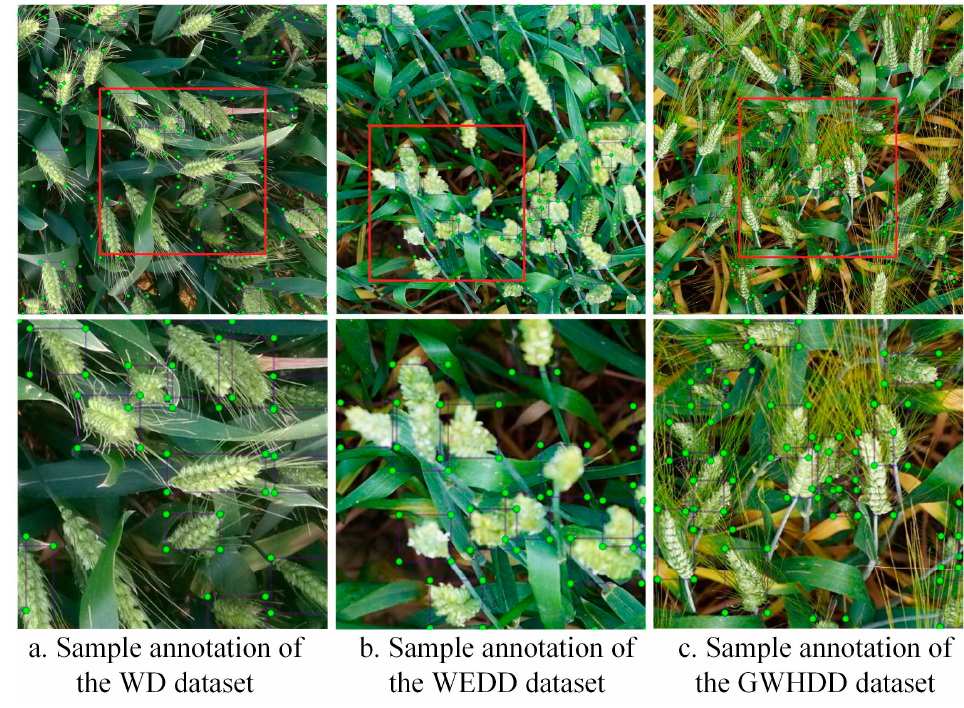
Figure 2. Example of labeling with LabelImg.